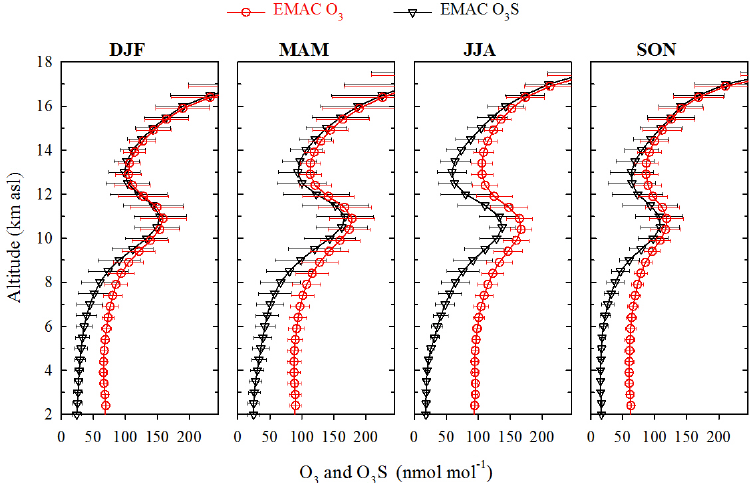
Figure 5. Average vertical profiles of EMAC-simulated ozone (O 3 ) and stratospheric ozone tracer (O 3 s) during the SOPs over Nainital aggregated into four seasons: DJF (winter), MAM (spring/pre-monsoon), JJA (summer monsoon), and SON (autumn) for the period 2000– 2014.